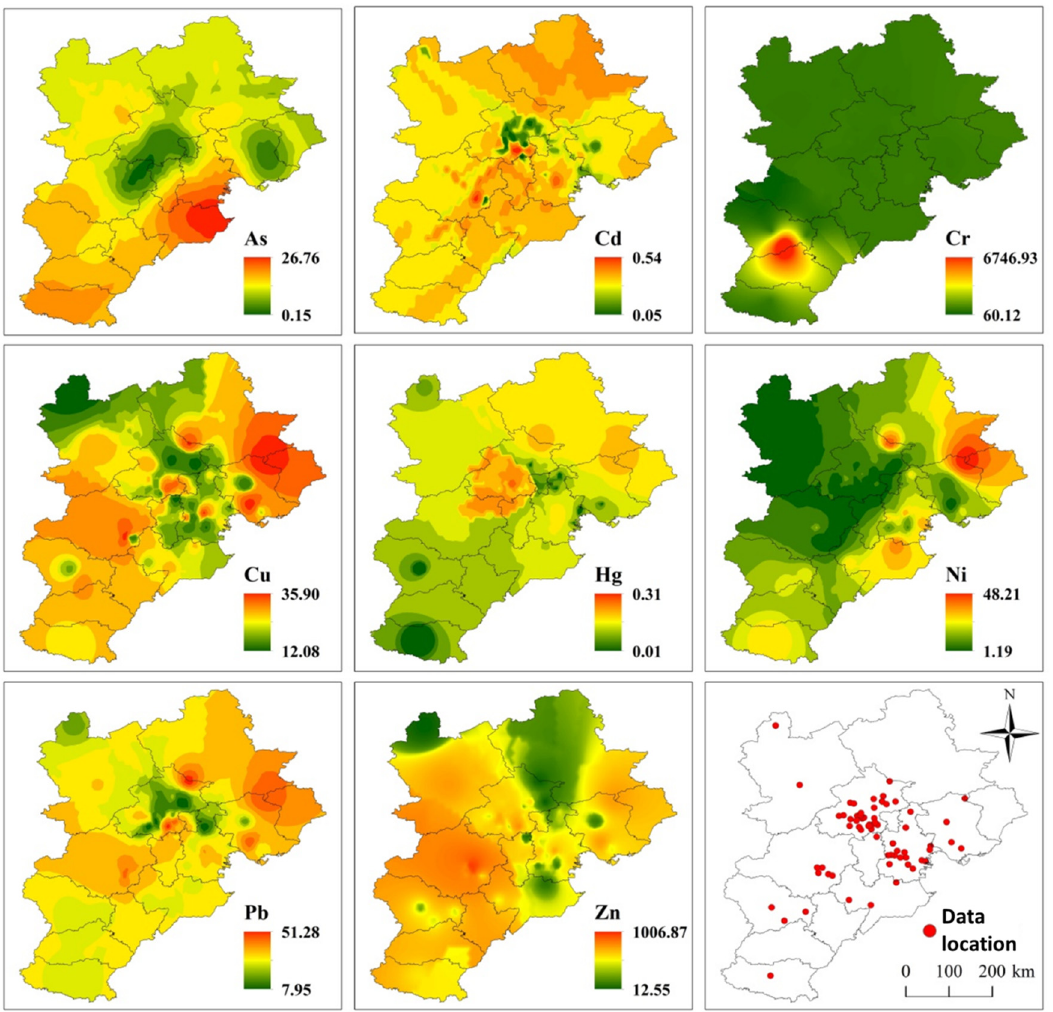
Figure 3. Distribution of PHE concentrations in BTH region (data were from published references).